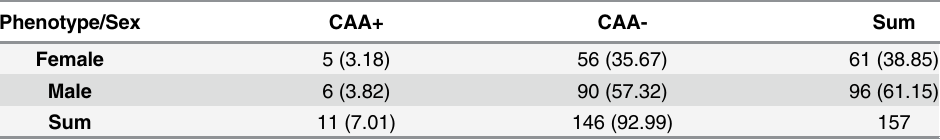
Table 1. Subject statistics used in this